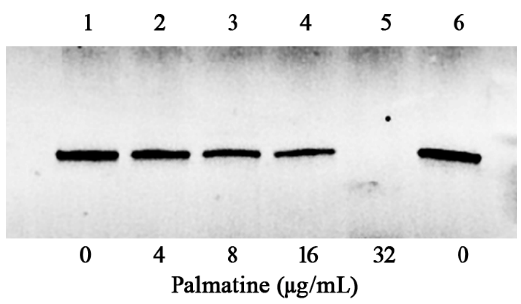
Figure 2. Western blot assay of aerolysin production in the supernatants after they were co-cultured with the indicated concentrations of palmatine.